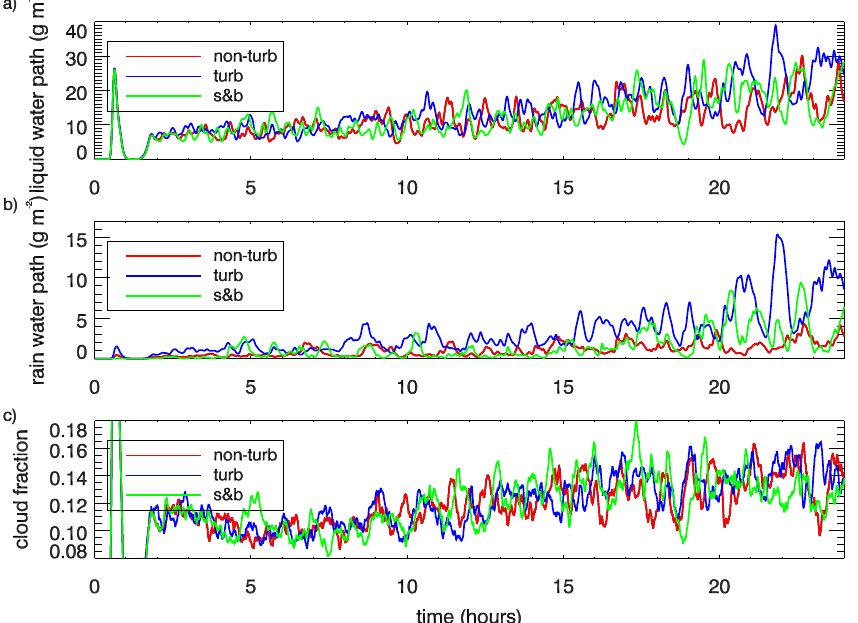
Figure 4. Time series of RICO (a) liquid (cloud and rain) water path (gm − 2 ) , (b) rain water path (gm − 2 ) and (c) cloud fraction for the simulations that use the turbulent (blue) and non-turbulent (red) microphysics parameterisations of Franklin (2008) and the microphysics scheme of Seifert and Beheng (2001;